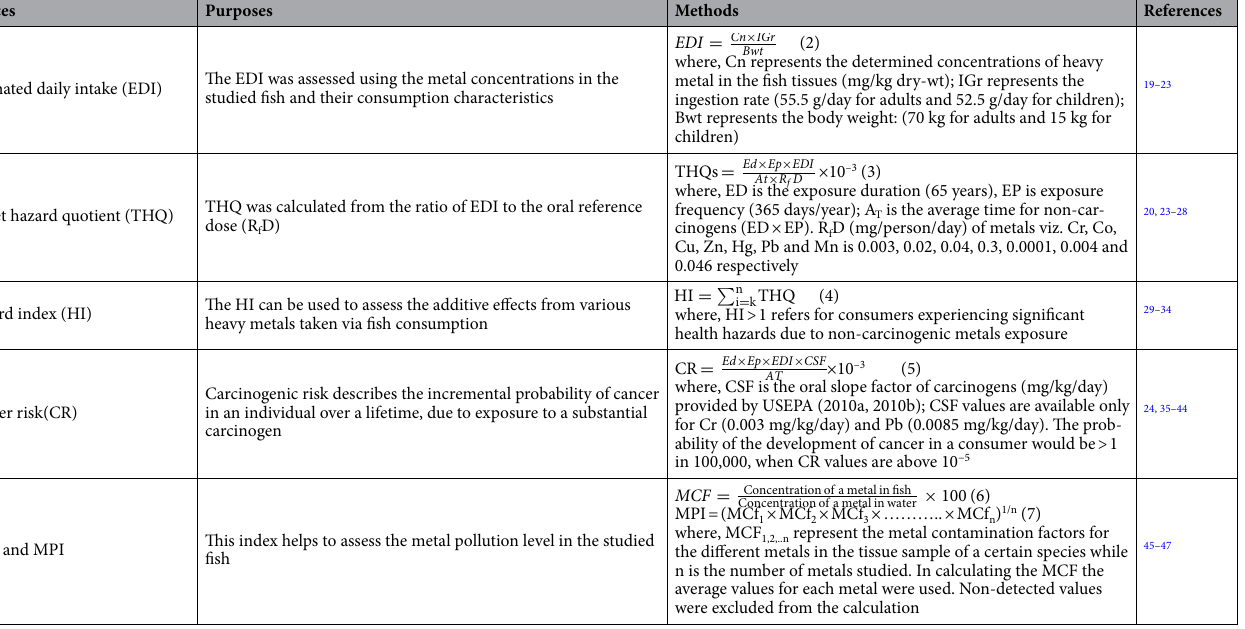
Table 3. Description of the metal indices utilized in study of the present fish samples.